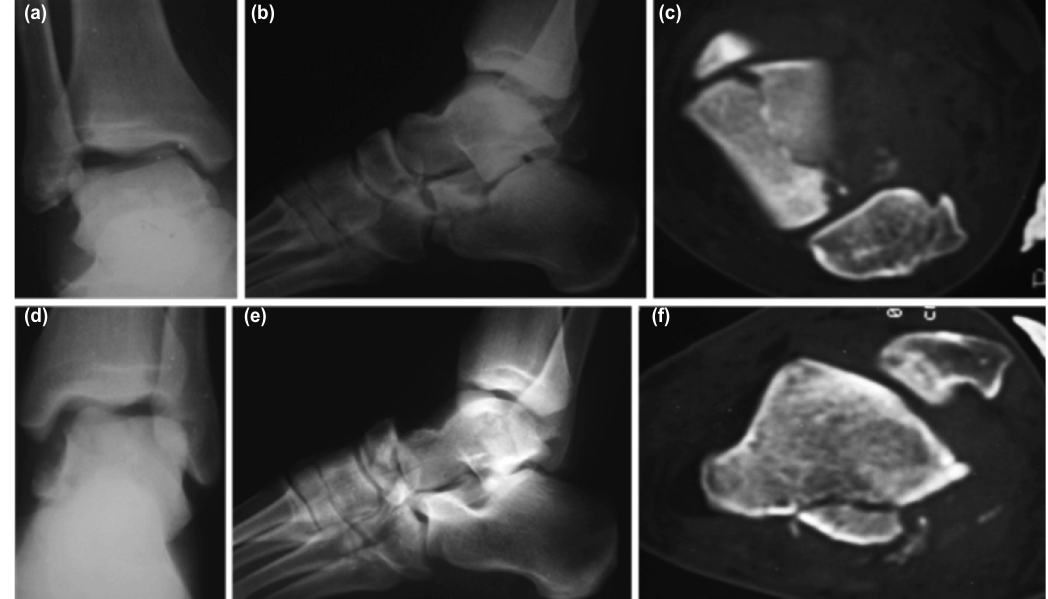
Pre-operative radio-imaging of both feet (a) anterior-posterior radiograph of right ankle showing coronal shear fracture of the Fig. 1: body of the talus. (b) lateral radiographs showing anterior process fracture of the calcaneus extending to the calcaneocuboid joint and nondisplaced navicular body fracture. (c) CT scan of the right foot and ankle, showing coronal shear fracture of the body of the talus. (d) anterior-posterior radiograph of left ankle showing subluxation of talus with no obvious fracture. (e) lateral radiographs showing displaced fracture of the navicular body with talo-navicular subluxation. (f) CT scan of the left foot and ankle showing fracture of posteromedial process fracture of the talus.